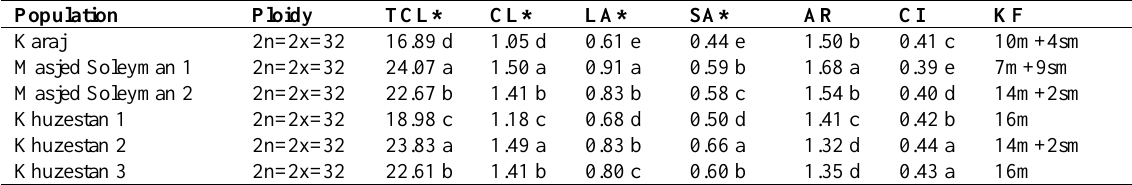
Table 2. Average of measured chromosomal traits in the studied populations Population Ploidy